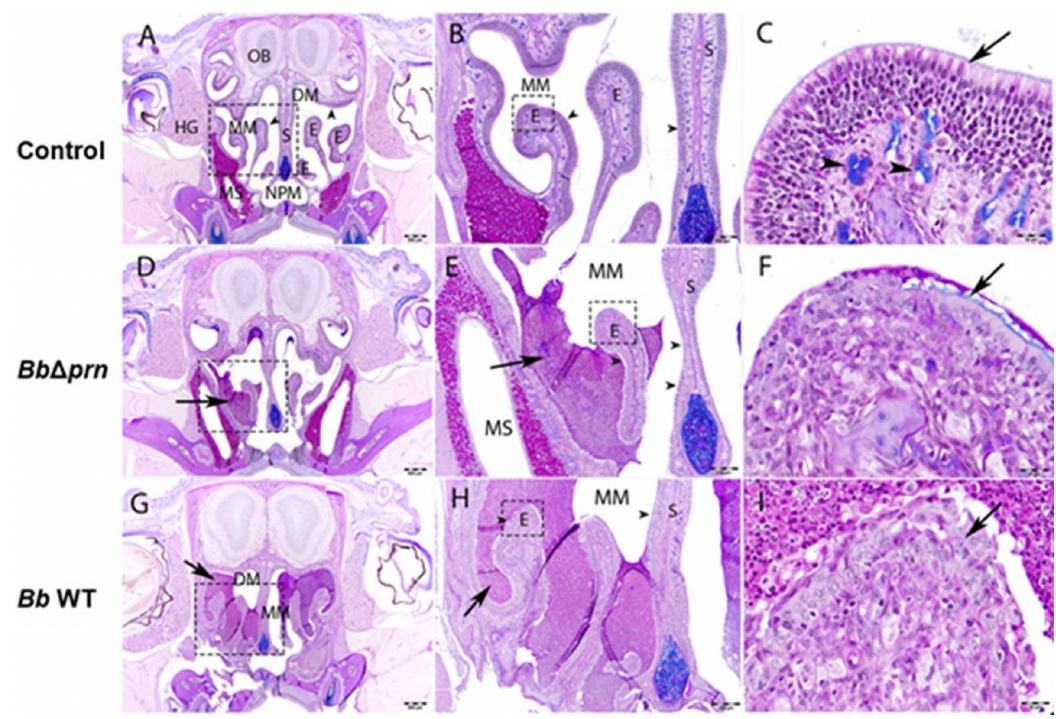
Fig 2. B . bronchiseptica PRN induces inflammation and mucus secretion. (A-I) Coronal sections of the nasal cavity (level 4) of control or B . bronchiseptica (Bb Δ prn or Bb WT strains) infected C57BL/6J mice at 14 dpi with stained with Alcian blue–Periodic acid-Schiff hematoxylin (AB-PASH) stain. A) Image of normal nasal cavity, level 4, from a PBS-inoculated control mouse. At this level, a layer of olfactory epithelium (arrowheads) lines the nasal mucosa within the dorsal and middle nasal meatus. Scale bar = 500 μ m. B) Higher magnification of Fig 2A (dashed rectangle) showing ethmoturbinates (E) and septum (S) lined by a layer of olfactory epithelium (arrowhead) within the middle meatus (MM). Scale bar = 200 μ m. C) Higher magnification of Fig 2B (dashed rectangle) showing an ethmoturbinates lined by olfactory epithelium (arrow). Arrowhead points to a mucus producing (alcian blue- positive) gland within the lamina propria. Scale bar = 20 μ m. D) Image of the nasal cavity, level 4, from a mouse inoculated with Bb Δ prn . The arrow points to a moderate accumulation of mucopurulent within the middle meatus. Scale bar = 500 μ m. E) Higher magnification of Fig 2D (dashed rectangle) showing deposition of mucopurulent exudate (arrow) covering the olfactory epithelium (arrowhead) within the middle meatus (MM). There is thinning of the olfactory epithelium (arrowheads) along the septum (S) and ethmoturbinate (E). Scale bar = 200 μ m. F) Higher magnification of Fig 2E (dashed rectangle) showing an ethmoturbinate. There is loss of olfactory epithelium and replacement by ciliated epithelium covered by a thin layer of mucus (arrow). There is loss of mucus producing glands within the lamina propria. Scale bar = 20 μ m. G) Image of the nasal cavity, level 4, from a B . bronchiseptica (RB50 )- inoculated mouse. The arrow points to a severe accumulation of mucopurulent within the dorsal (DM) and middle meatus (MM). Scale bar = 500 μ m. H) Higher magnification of Fig 2G (dashed rectangle) showing deposition of mucopurulent exudate (arrow) covering the olfactory epithelium within the middle meatus (MM). There is thinning and loss of the olfactory epithelium (arrowheads) along the septum (S) and ethmoturbinate (E). Scale bar = 200 μ m. I) Higher magnification of Fig 2H (dashed rectangle) showing an ethmoturbinate. Large numbers of PAS-positive neutrophils cover the ethmoturbinate. There is total loss of olfactory epithelium and replacement by non-ciliated epithelium (arrow). There is loss of mucus producing glands within the lamina propria. Scale bar = 20 μ m. Abbreviations: Dorsal Meatus (DM); Ethmoturbinate (E); Harderian Gland (HG); Maxillary Sinus (MS); Middle Meatus (MM); Nasopharyngeal Meatus (NPM); Olfactory Bulb (OB); Septum (S). There were 5 mice in each time point per